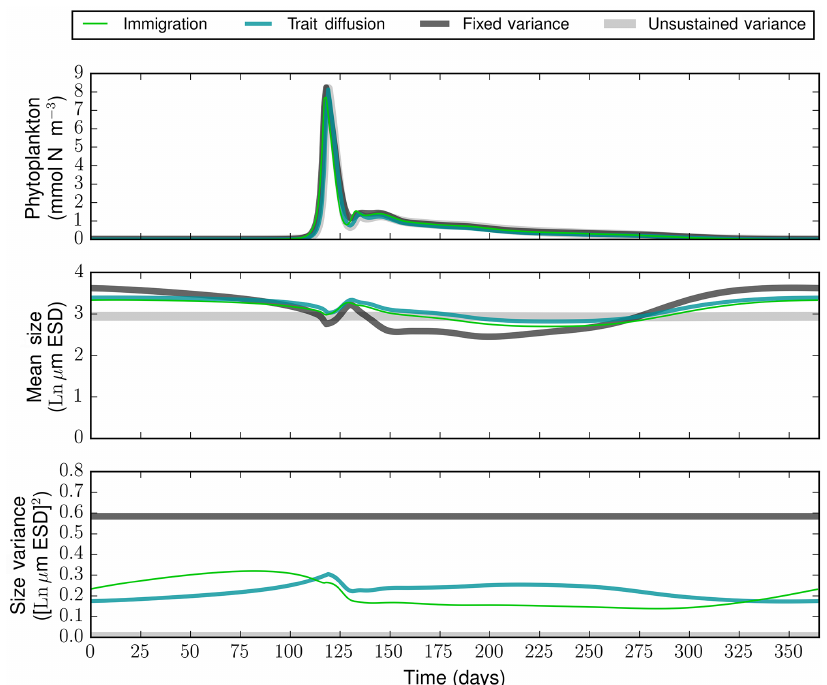
Figure 6. Dynamics of the size-structured phytoplankton community and its functional size diversity for the four variance treatments (see